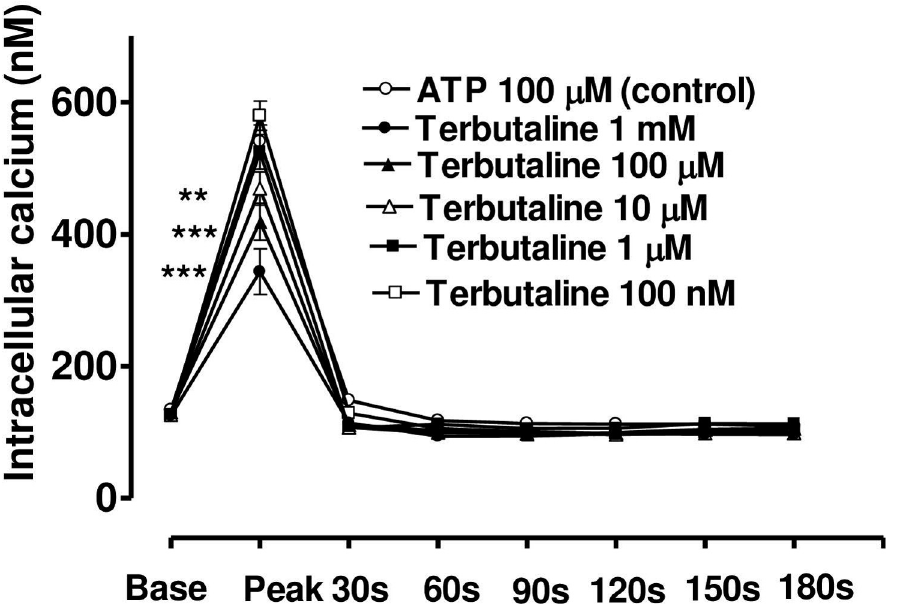
Fig 11. Effect of increasing concentration of terbutaline on the Ca 2+ -mobilizing response of ATP (100 μ M) in bovine cultured CE, in the present of extracellular calcium and NiCl 2 (4mM). Terbutaline’s effect on both the peak Ca 2+ transient and at selected time intervals thereafter had been shown. Cultured cells were incubated for 6 min with appropriate concentration of terbutaline in HEPES buffered Krebs’ solution containing 4mM NiCl 2 and1.8mM calcium. The cells were then exposed to 100 μ M of ATP. Each point represents a mean ± s.e.mean of 8–12 experiments. Significance of differences between incubations with or without terbutaline; �� p < 0.01 and ��� p < 0.001, Bonferroni’s multiple comparison test. Base value indicates the [Ca 2+ ] i prior to addition of ATP.